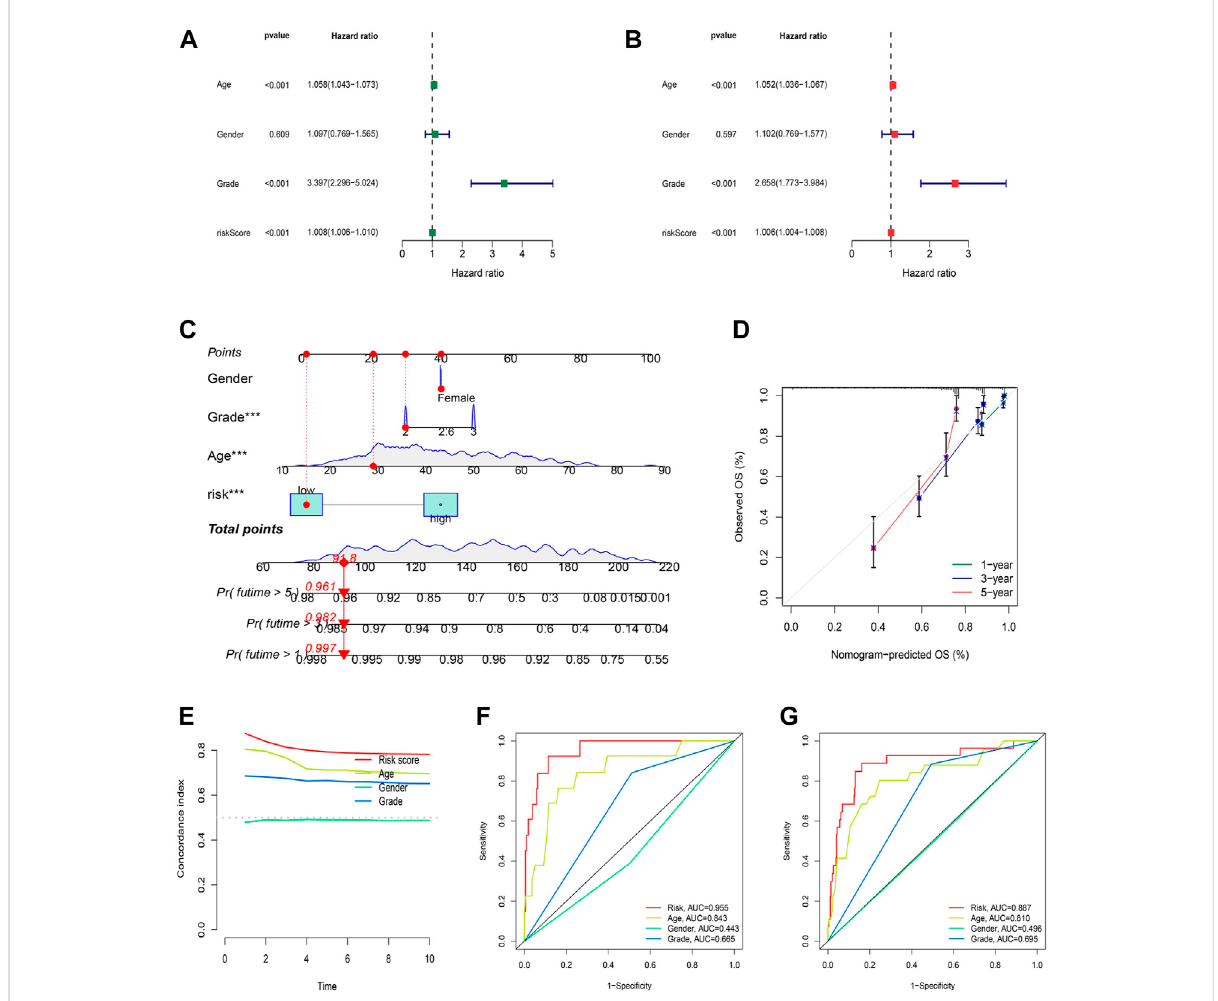
FIGURE 6 Constructionand validation ofthenomogram. (A) Univariate regression analysis inthetestingset. (B) Multivariate Coxregression analysis